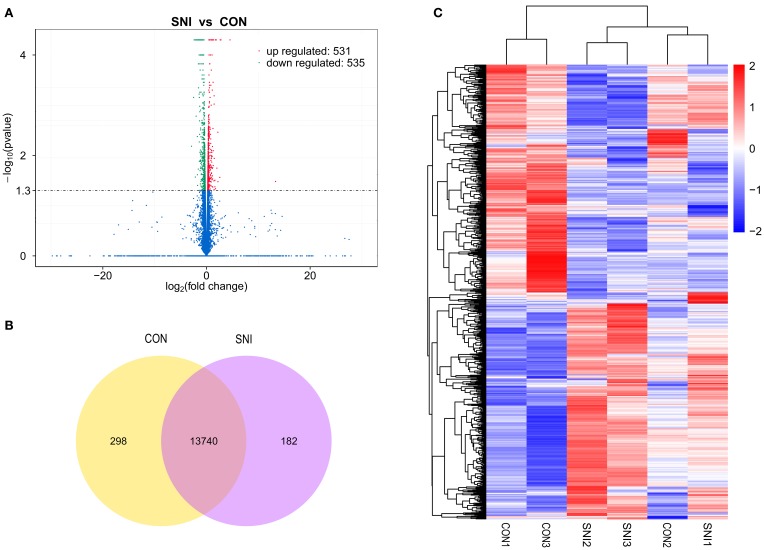
The expression profiling changes of mRNAs in spinal cord of SNI rats Vocalno Plot indicate up and down regulated mRNAs of rats in group SNI compared with group CON (A); Venn diagram showing the number of overlap mRNAs in group SNI compared with group CON (B); Heat map of mRNAs showing hierarchical clustering of changed mRNAs of rats in group SNI compared with group CON. In clustering analysis, up- and down-regulated genes are colored in red and blue, respectively (C).